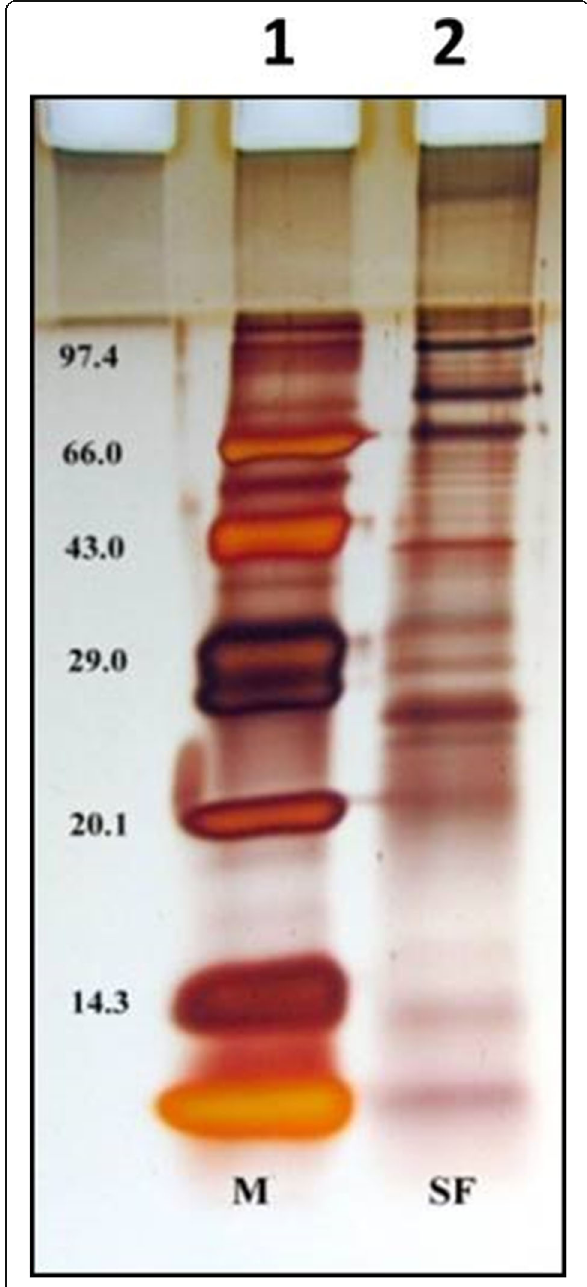
Fig. 2 SDS-PAGE showing protein profile of SCF. 12% SDS PAGE gel showing proteins present in SCF as observed by silver staining of the gel. Lane 1 = protein molecular weight marker; Lane 2 = crude SCF. SCF was found to be a mixture of various proteins and